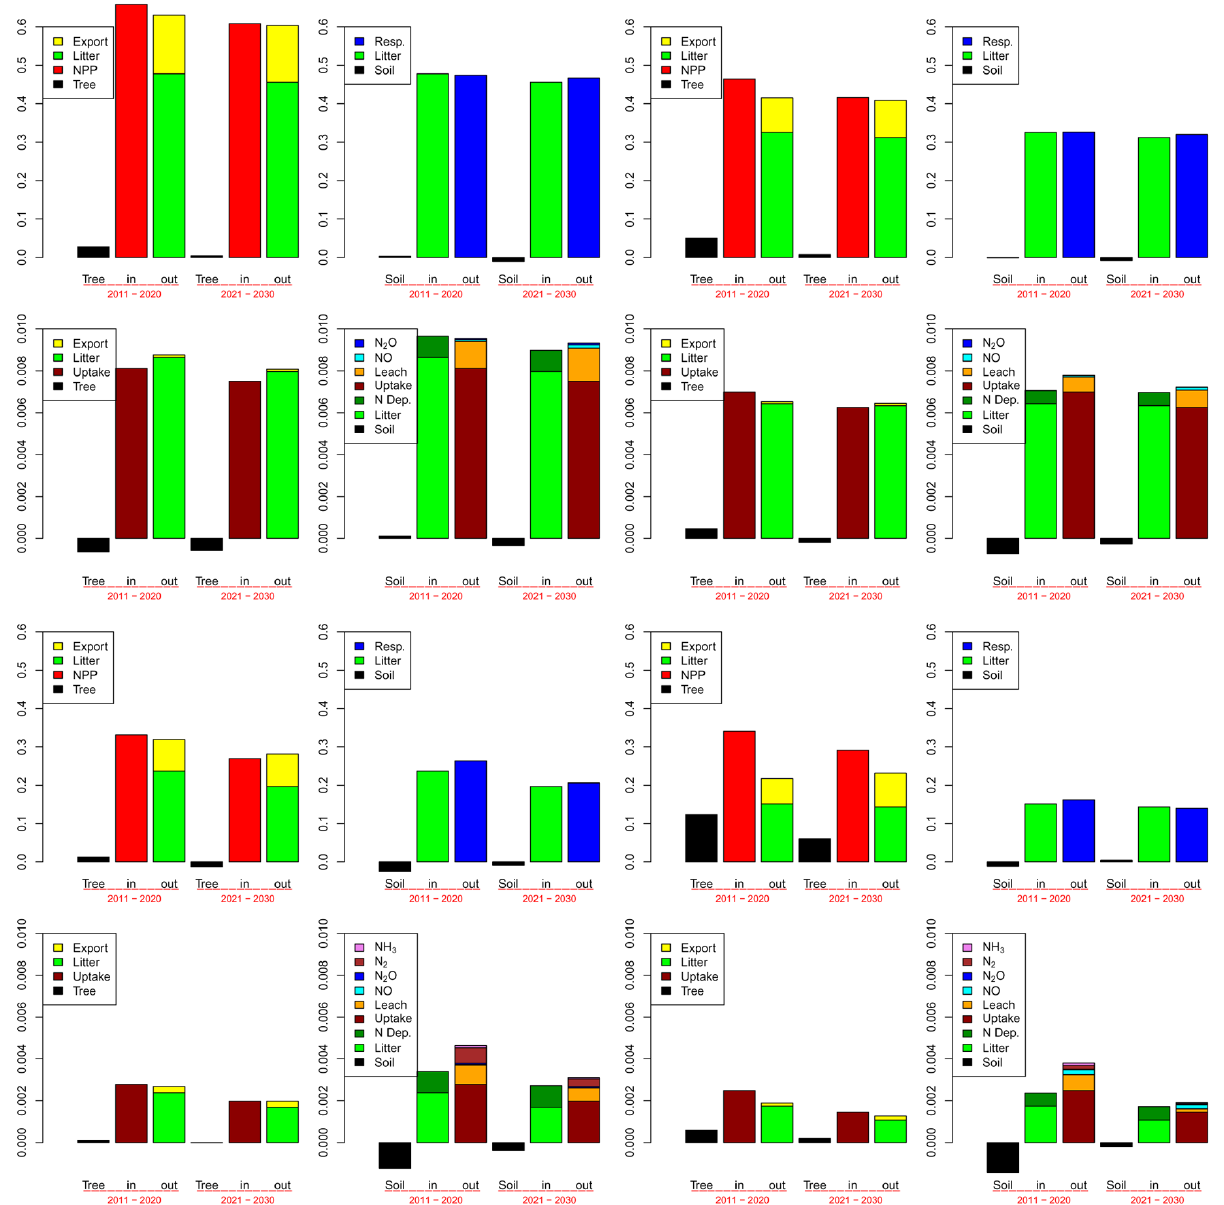
Fig. 2. European average carbon and nitrogen budgets. The plots are grouped in sets of four in which the top and bottom rows are carbon and nitrogen budgets, respectively. The left plots are for trees and the right plots soil. The top set of plots are for BASFOR and the bottom set for LandscapeDNDC. The units are kgC or Nm − 2 yr − 1